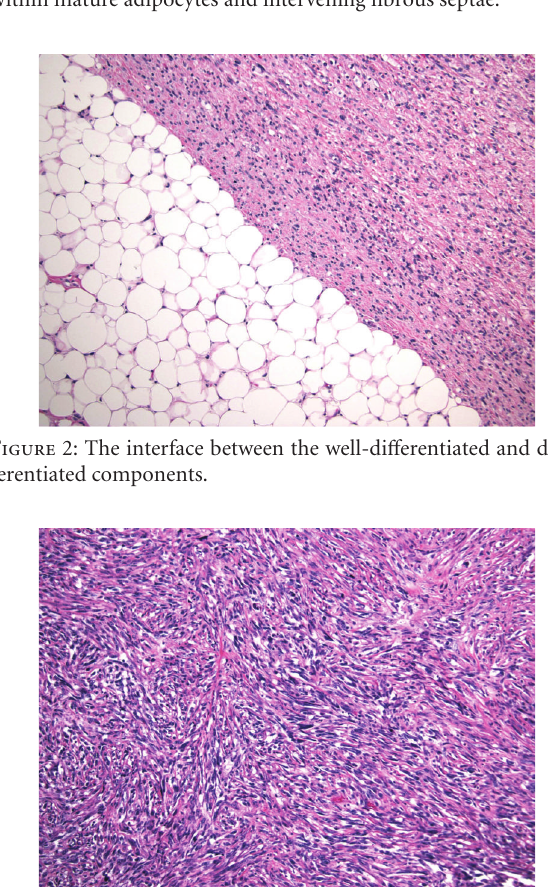
Figure 1: Well-di ff erentiated component of the liposarcoma, show- ing atypical cells with nucleomegaly and hyperchromasia scattered within mature adipocytes and intervening fibrous septae.